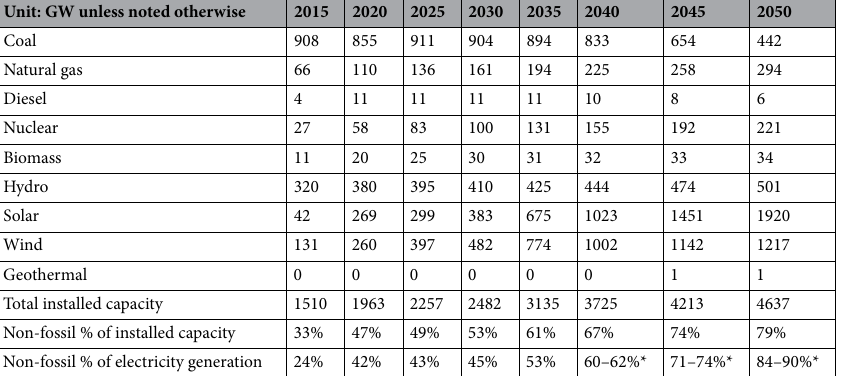
Unit: GW unless noted